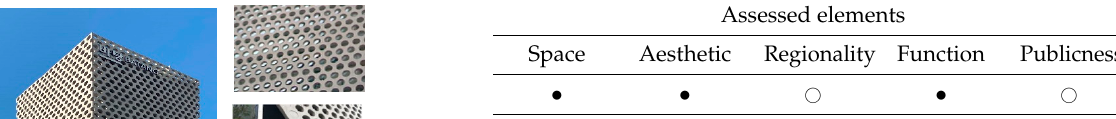
Table 3. Structural facades: Urban Hive (Archium 2008).